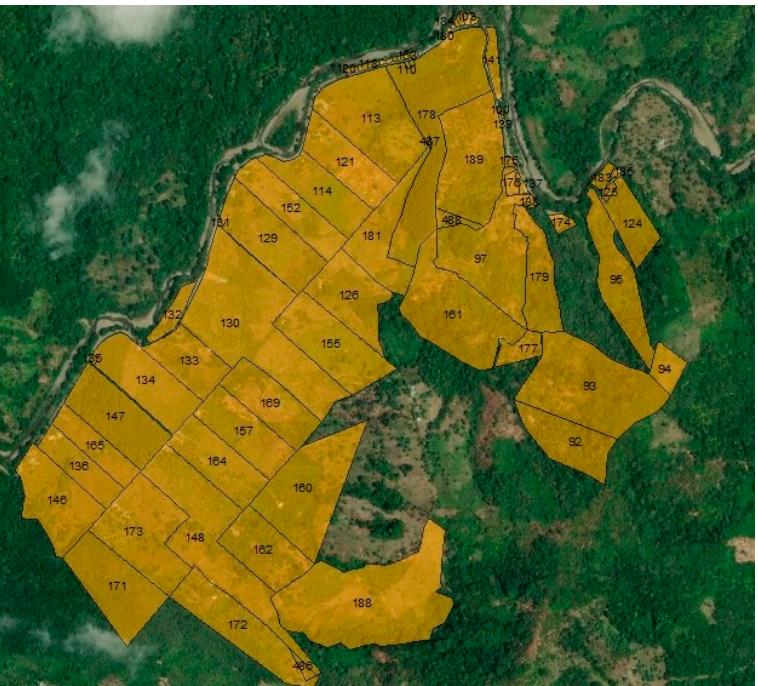
Figure 16. Structured dataset of Los Mandarinos.